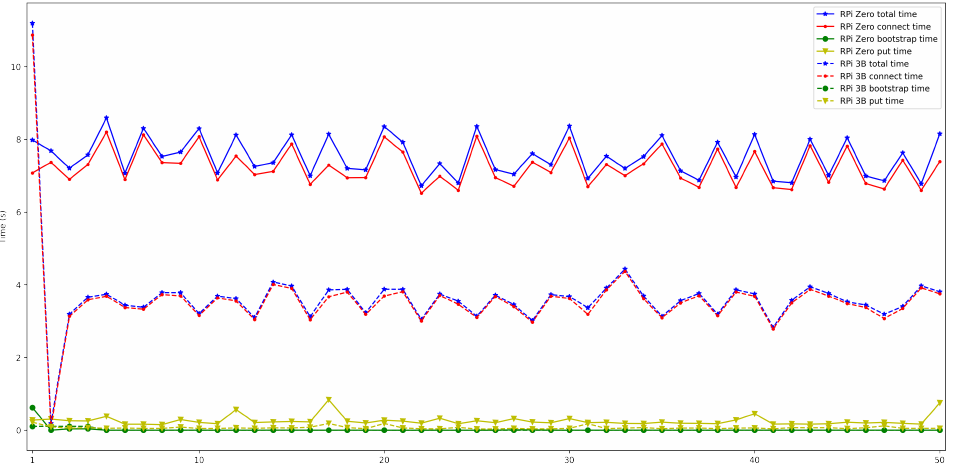
Figure 18. Latency when using Raspberry Pi Zero/3B+ gateways for 200 peers connected to the bootstrap node.